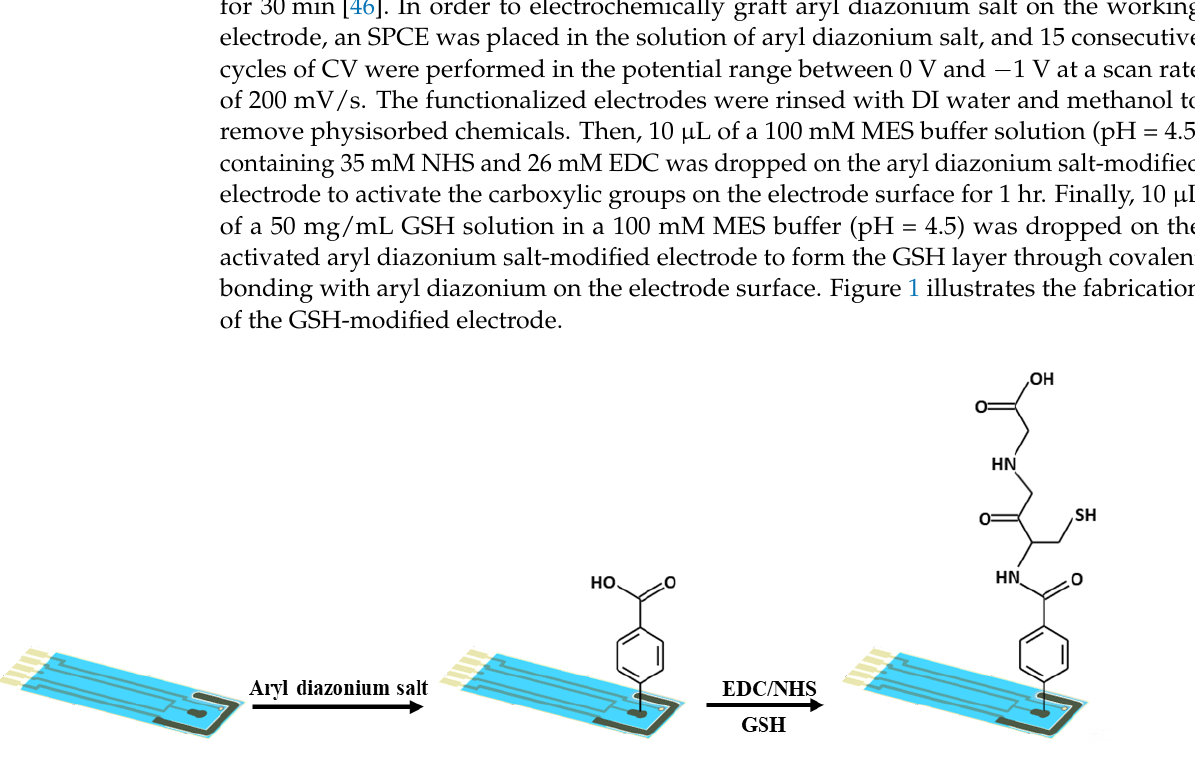
Figure 1. A schematic illustrating the preparation procedure of the GSH-modified electrode.